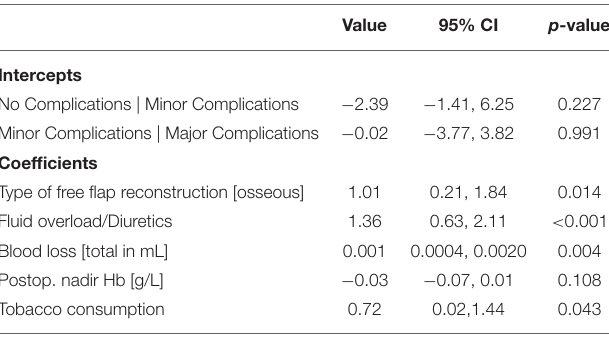
TABLE 3B | Ordinal regression model summary with the outcome “Clavien-Dindo classification